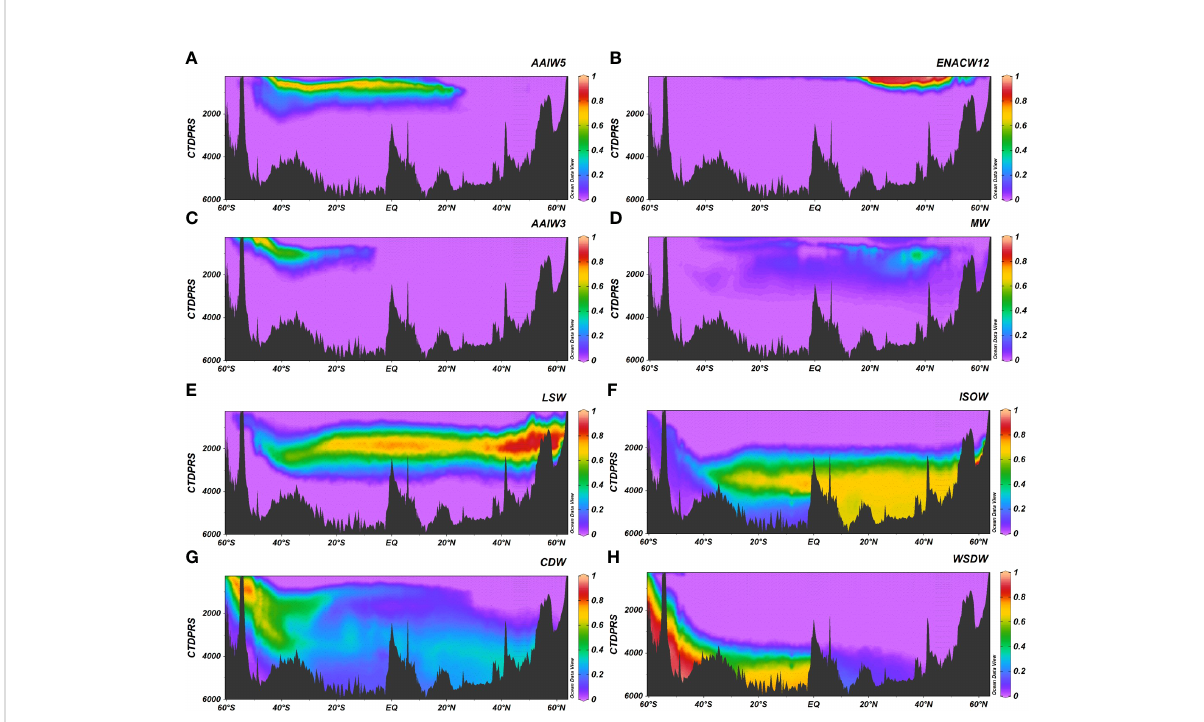
FIGURE 5 A16 section for the contribution of the water masses (A) AAIW5, (B) ENACW12, (C) AAIW3, (D) MW, (E) LSW, (F) ISOW, (G) CDW and (H) WSDW. Figure with the Ocean Data View software (Schlitzer, 2015).